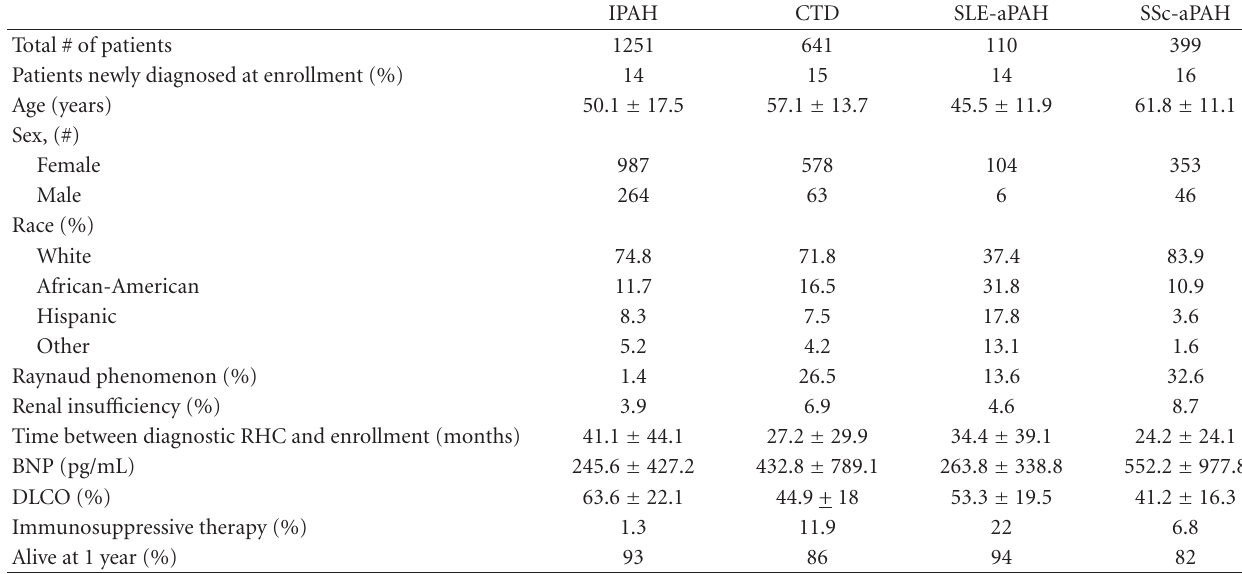
Table 1: REVEAL registry demographic and diagnostic